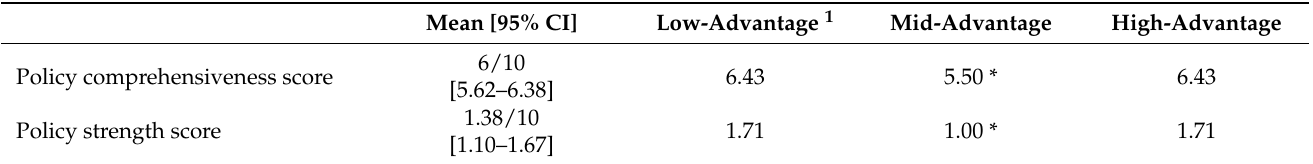
Table 1. School food policy comprehensiveness and strength scores. Mean [95% CI] Low-Advantage 1 Mid-Advantage High-Advantage Policy comprehensiveness